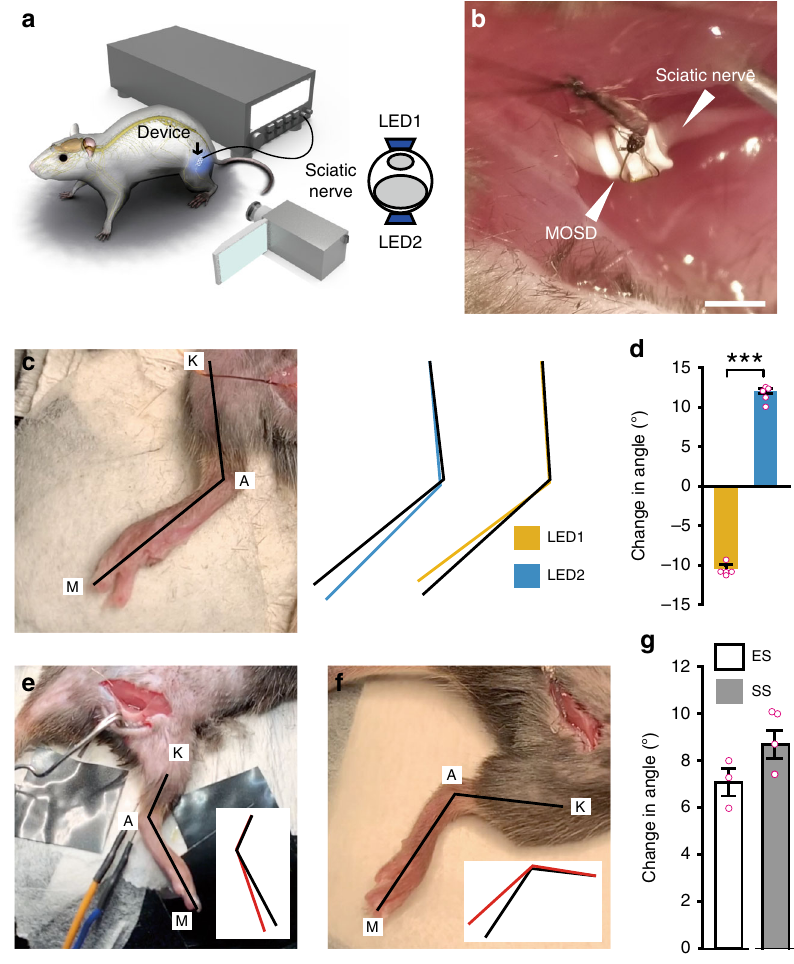
Fig. 4 MOSD induced selective extension and fl exion in the ankle joint. a Schematic diagram of Thy1 - ChR2 mice implanted with the MOSD. b An image of the MOSD fi rmly wrapped around the sciatic nerve. c The knee joint (K), ankle (A), and metatarsal head (M) were labeled in an anesthetized mouse. Black lines represented the original position of the K-A-M. Blue and Yellow lines represented the positions of K-A-M in response to mini-LED1 and mini-LED2. d Average change in the angle of the ankle joint in response to mini-LED1 and mini-LED2 (light turned on at 20. 4 mW for 20 msec with 2-sec intervals, calculated light intensity at the mini-LED: 888 mW mm − 2 ; in the middle: 398 mW mm − 2 ; at the far end: 134 mWmm − 2 ; n = 5 mice, Paired t test; *** P < 0.001). e Representative image of the position of the leg before electrical stimulation (0.5 – 0.7 mA, 0.2 msec). Black line in the inset represented the original position of K-A-M. Red line in the inset represented the position of K-A-M after electrical stimulation. f Representative image of the position of the leg before the single-site optogenetic stimulation (81.6 mW, 20 msec-on/2sec-off). Black line in the inset represented the original position of K-A-M. Red line in the inset represented the position of K-A-M after electrical stimulation. g Average change in the angle of the ankle joint in response to electrical stimulation ( n = 3 mice) and single-site optogenetic stimulation ( n = 5 mice, 81.6 mW). Data are presented as mean ± s.e.m. Extension was de fi ned as positive angle; fl exion was de fi ned as negative angle. ES: Electrical stimulation; SS: single-site optogenetic stimulation. Scale bar is 1 mm ( b